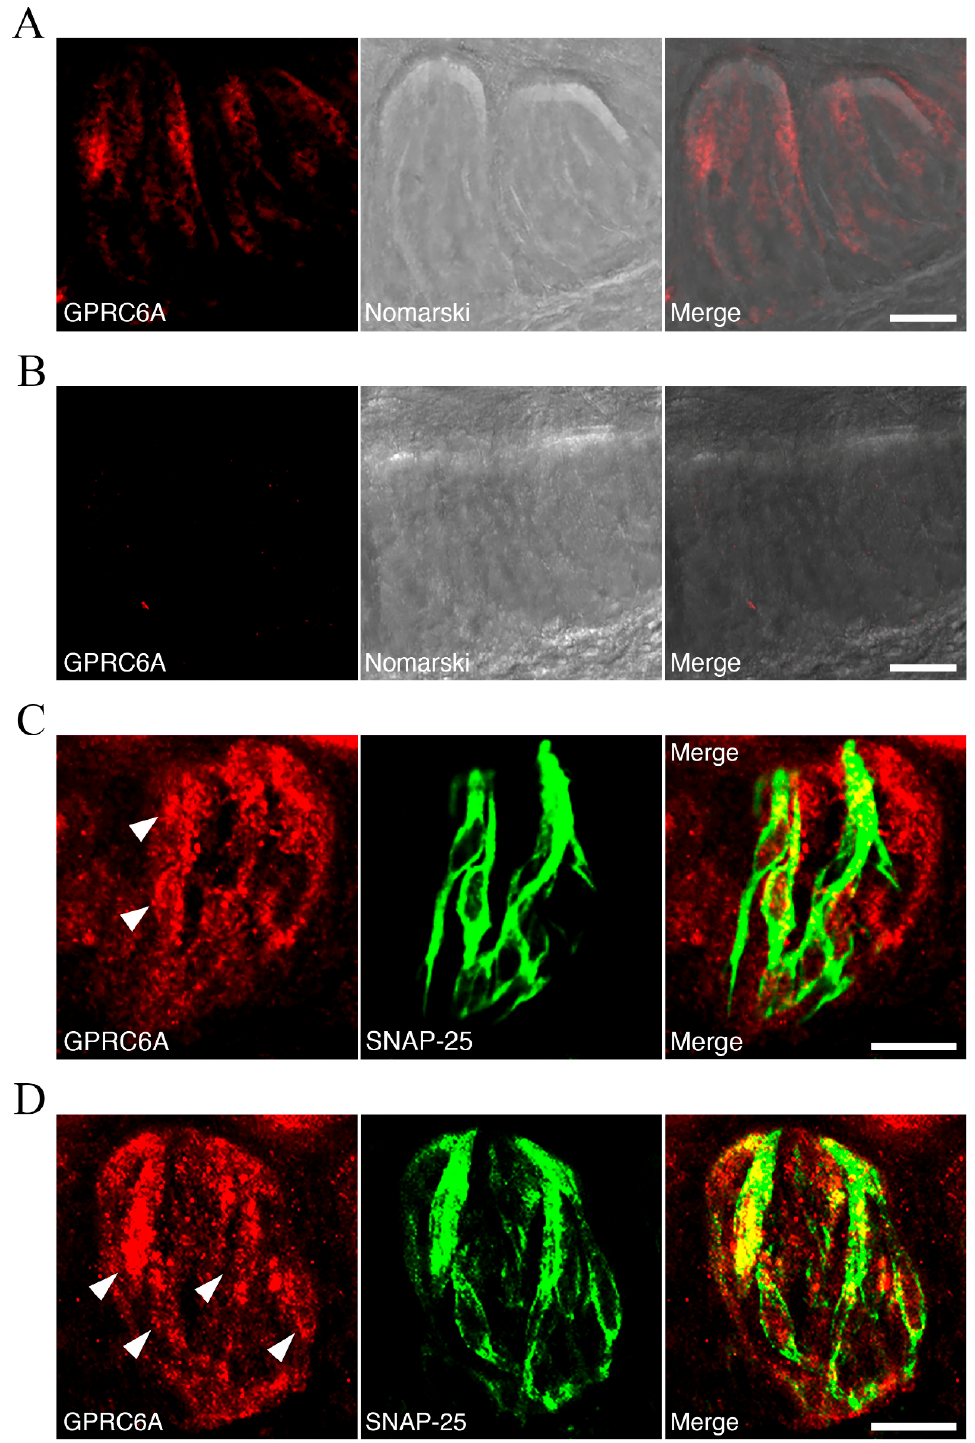
Figure 9. Immunohistochemical analysis of GPRC6A in taste cells of mouse circumvallate papilla taste buds. ( A , B ) Fluorescence micrographs of the taste buds immunostained with the anti-GPRC6A antibody in the absence ( A ) or presence ( B ) of the antigen peptide (left panels; middle panels, Nomarski images of the left panels; right panels, merged images of respective right and middle panels). ( C ) Immunoreactivity for GPRC6A is expressed in a small subset of type II taste cells. Shown are immunoreactivity for GPRC6A (red, left panel), immunoreactivity for a-gustducin (green, middle panel) and a merged image of both panels (right panel). Arrowheads indicate GPRC6A-positive type